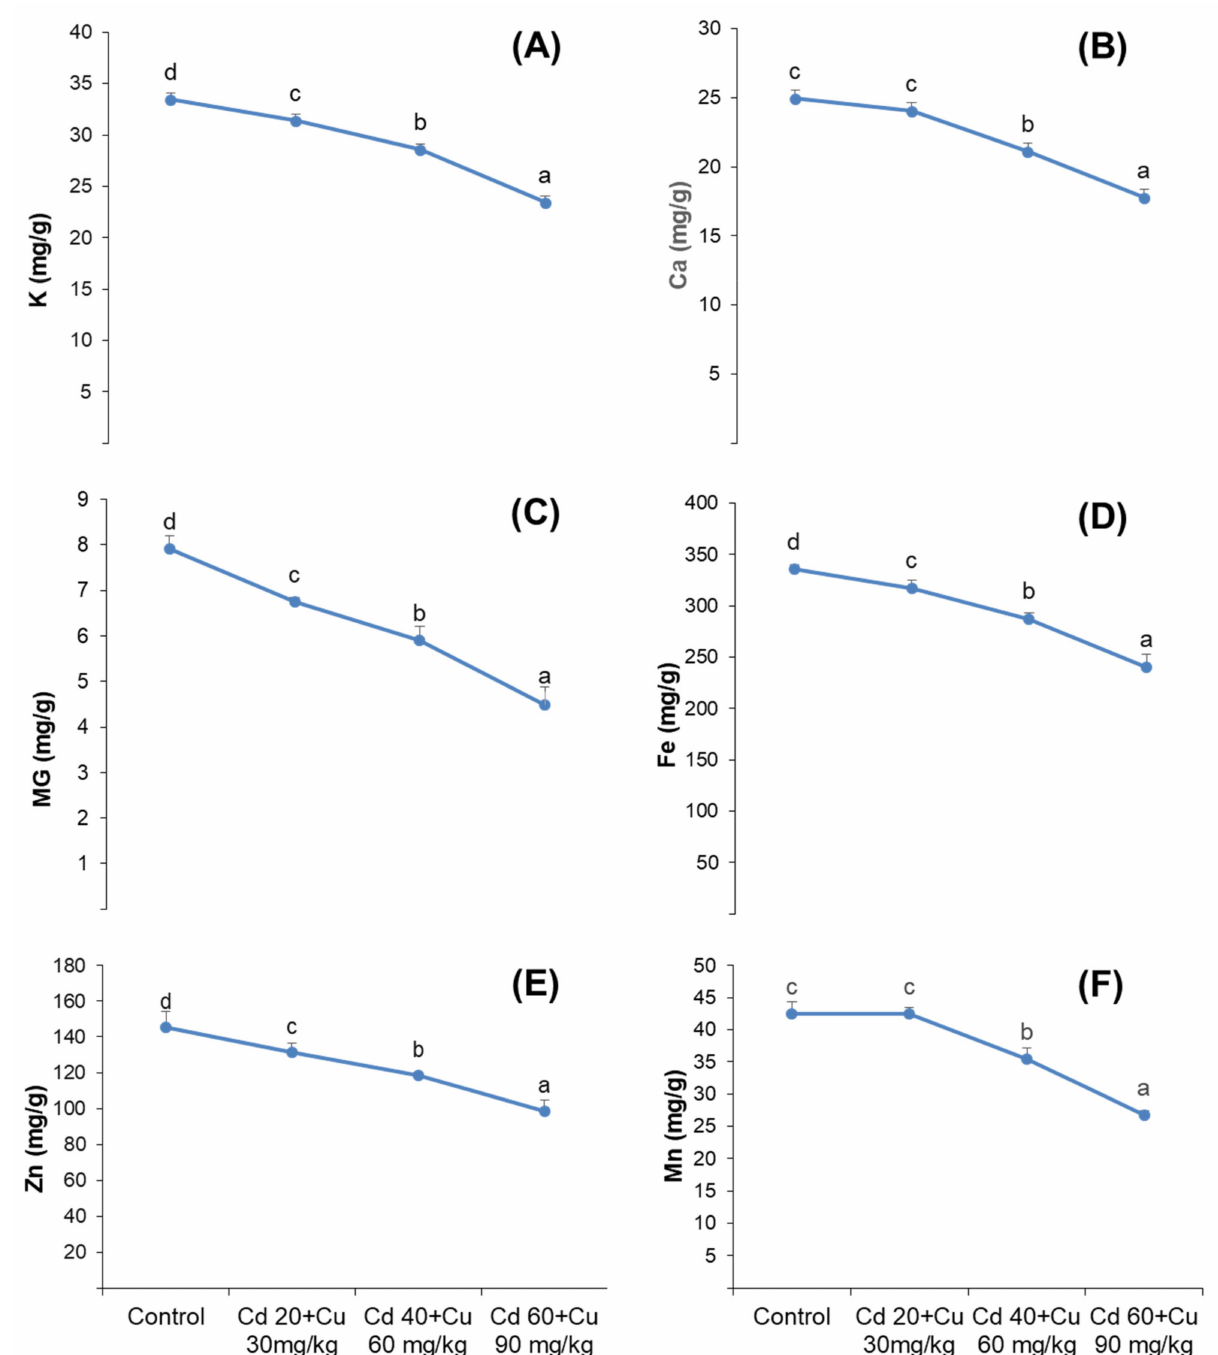
Figure 6. Effect of different cadmium and copper concentrations (0, Cd 20 + Cu 30 mg/kg, Cd 40 + Cu 60 mg/kg, and Cd 60 + Cu 90 mg/kg) on shoot macro-nutrient K + , Ca + , and Mg 2+ ( A – C ) and macro-nutrient Fe + , Zn, and Mn ( D – F ) contents in pigeon pea plant. Bars represent means from the three independent replicates; different letters indicate significant differences between the treatments at p <